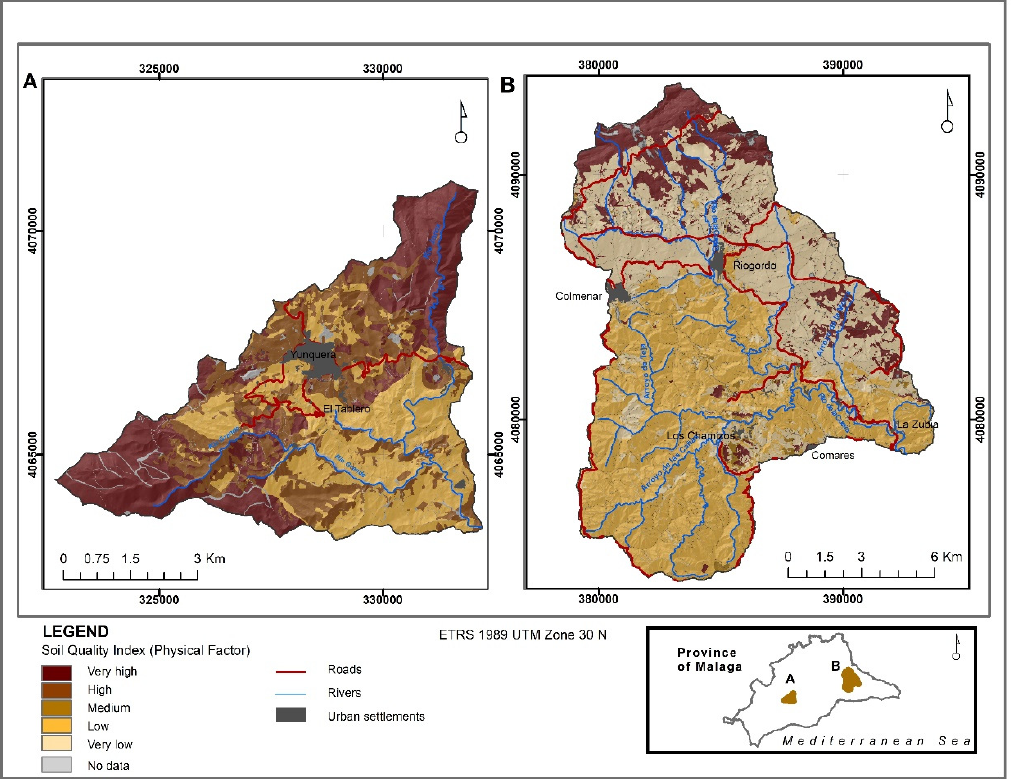
Figure 3. Physical factor in the soil quality index. Maps display the spatial distribution of each category of soil quality according to physical indicators in ( A ) GR and ( B ) BE.